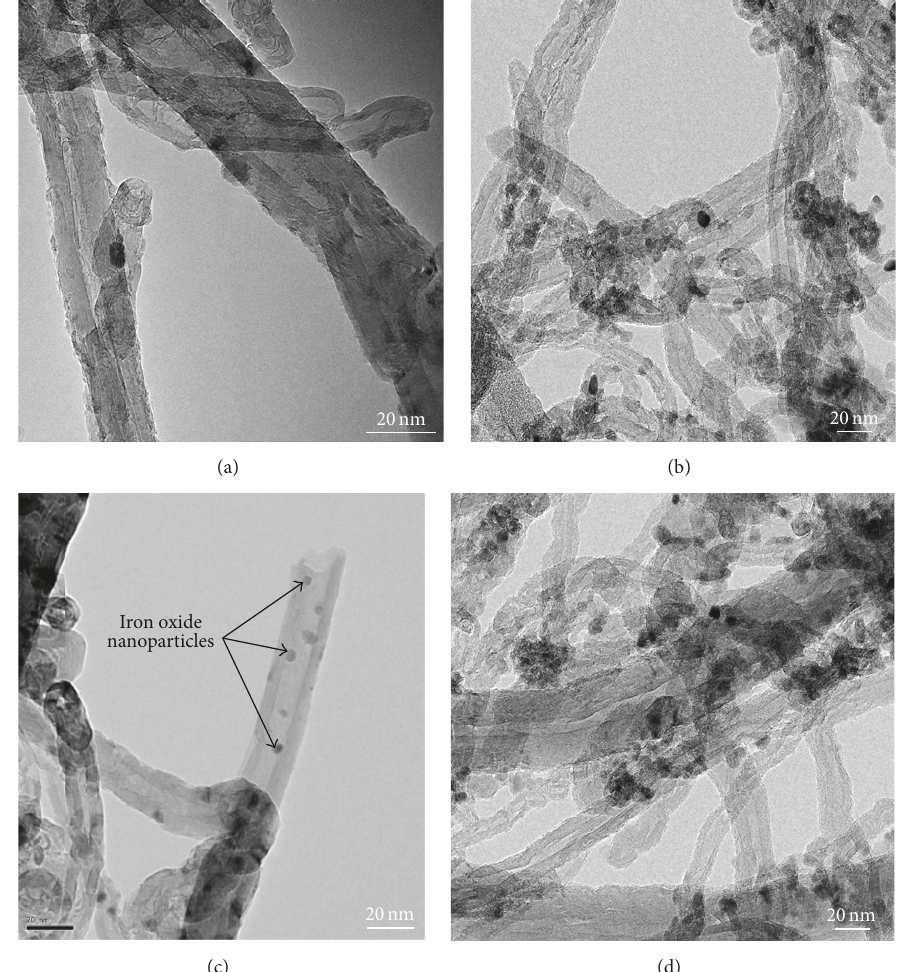
Figure 3: HRTEM images of (a) raw CNTs, (b) CNT-5% iron oxide, (c) CNT-10% iron oxide, and (d) CNT-20% iron oxide.